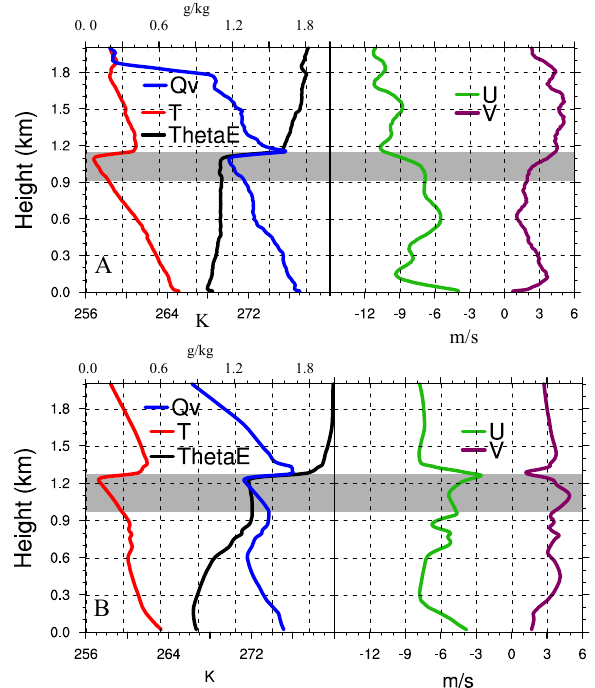
Fig. 2. Soundings of mid-day decoupled stratocumulus at Barrow, Alaska. (A) Measured 17:34Z 8 April 2008 at (71.33 ◦ N,156.61 ◦ W). (B) 50m LES simulation 20Z 8 April 2008 at (71.33 ◦ N,156.91 ◦ W; red star in Fig. 6). Gray shading marks the extent of the cloud